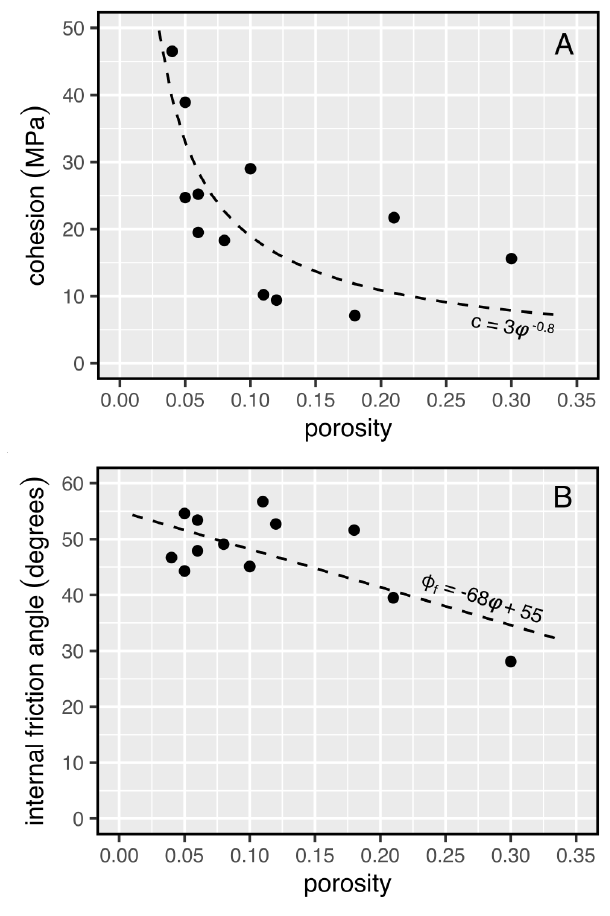
Figure 2: Laboratory-scale cohesion [A] and internal fric- tion angle [B] as a function of porosity for a range of vol- canic rock types and textures (andesite, basalt, dacite, and tuff) (data in Table 1). Empirical fits to the data are given as dashed